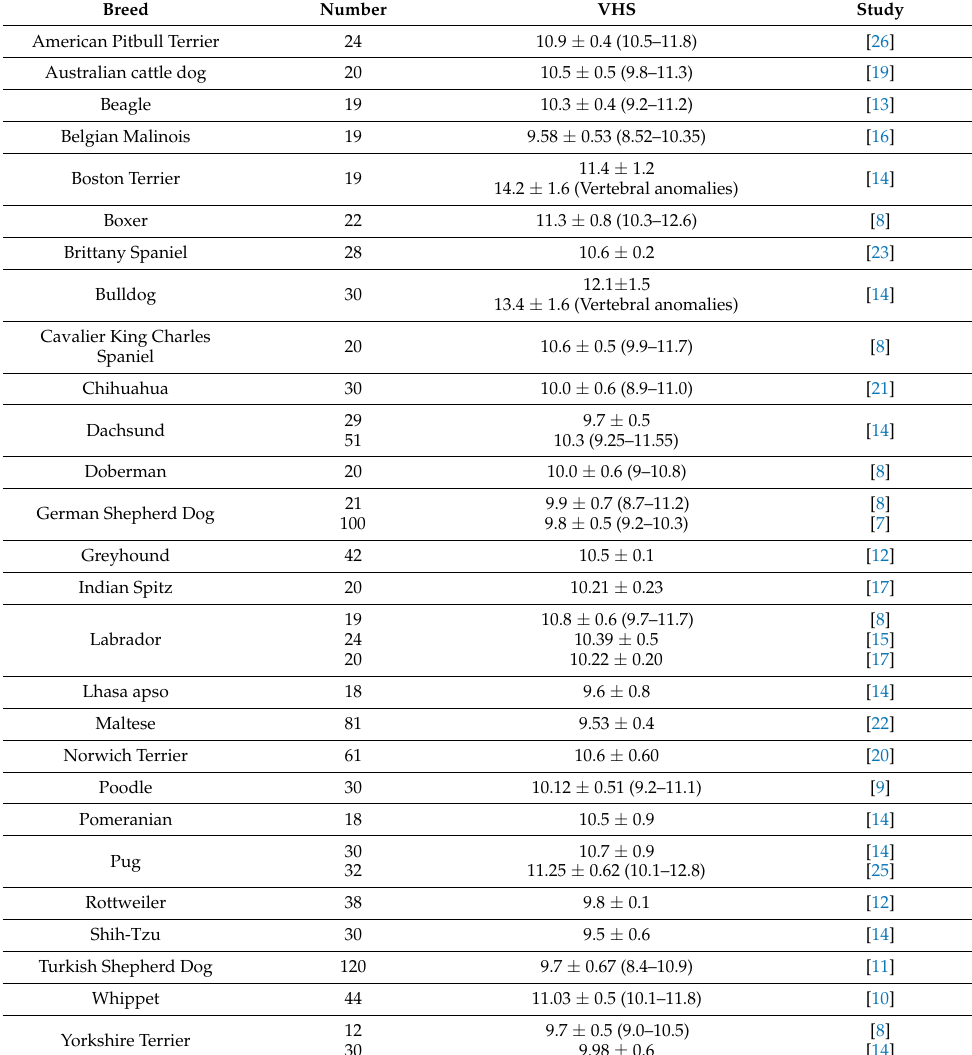
Table 3. Breed-specific VHS obtained in different studies since the original Vertebral Heart Size study was published by Buchanan and Bücheler in